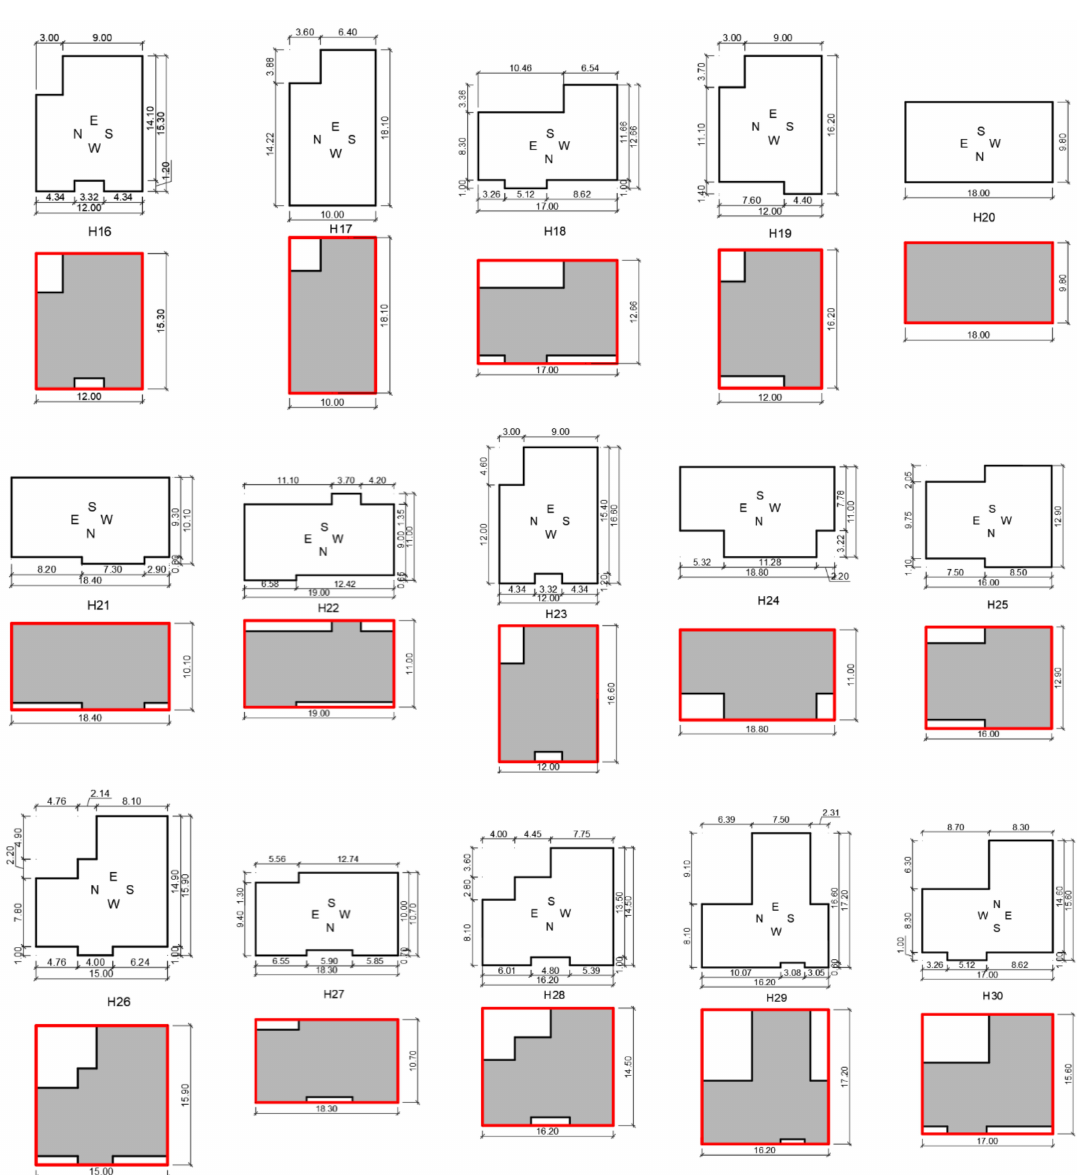
Figure A2. Building plans of the H16–H30 collection with cardinal